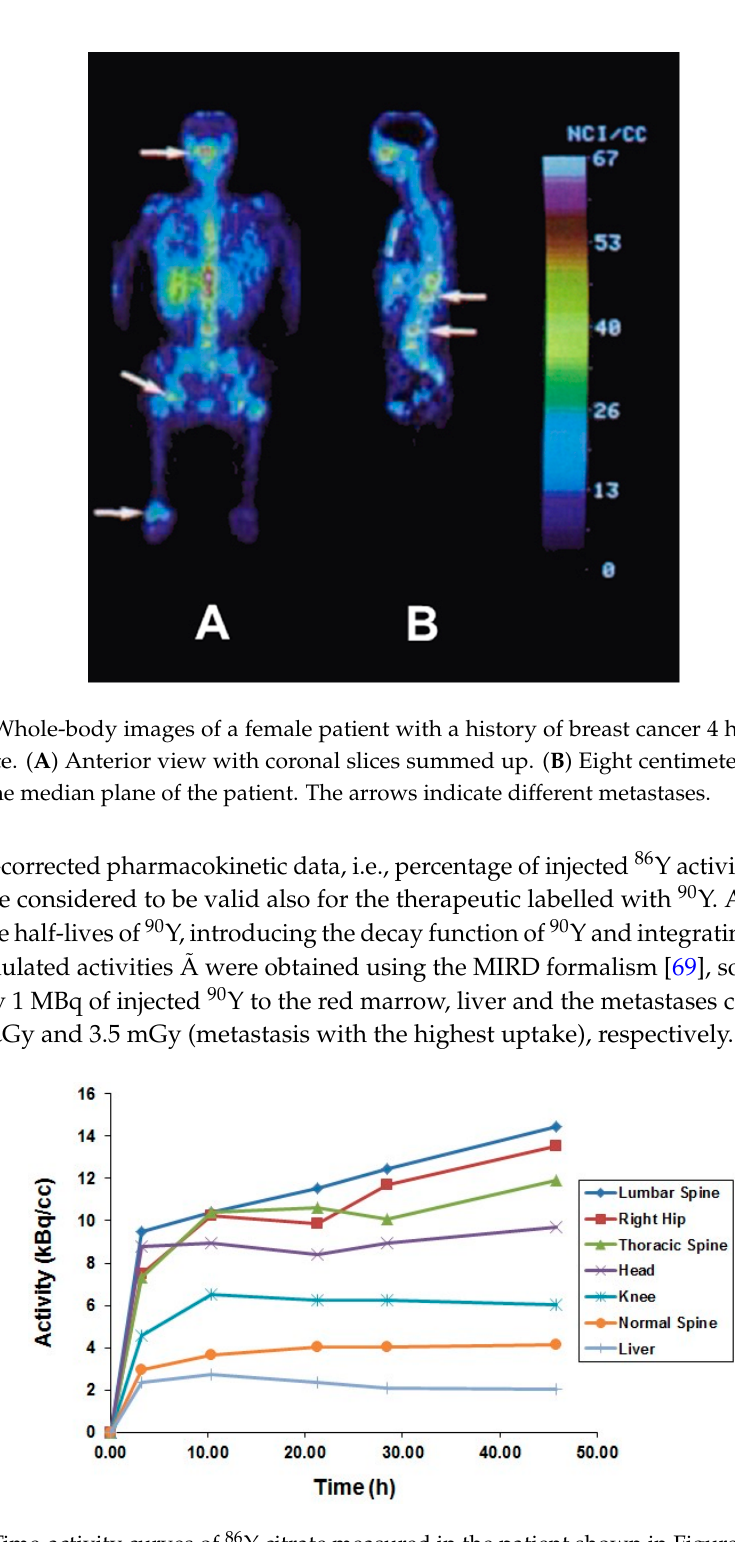
Figure 11. Time-activity curves of 86 Y-citrate measured in the patient shown in Figure 10. The upper five curves belong to the metastases indicated by arrows in Figure 10.